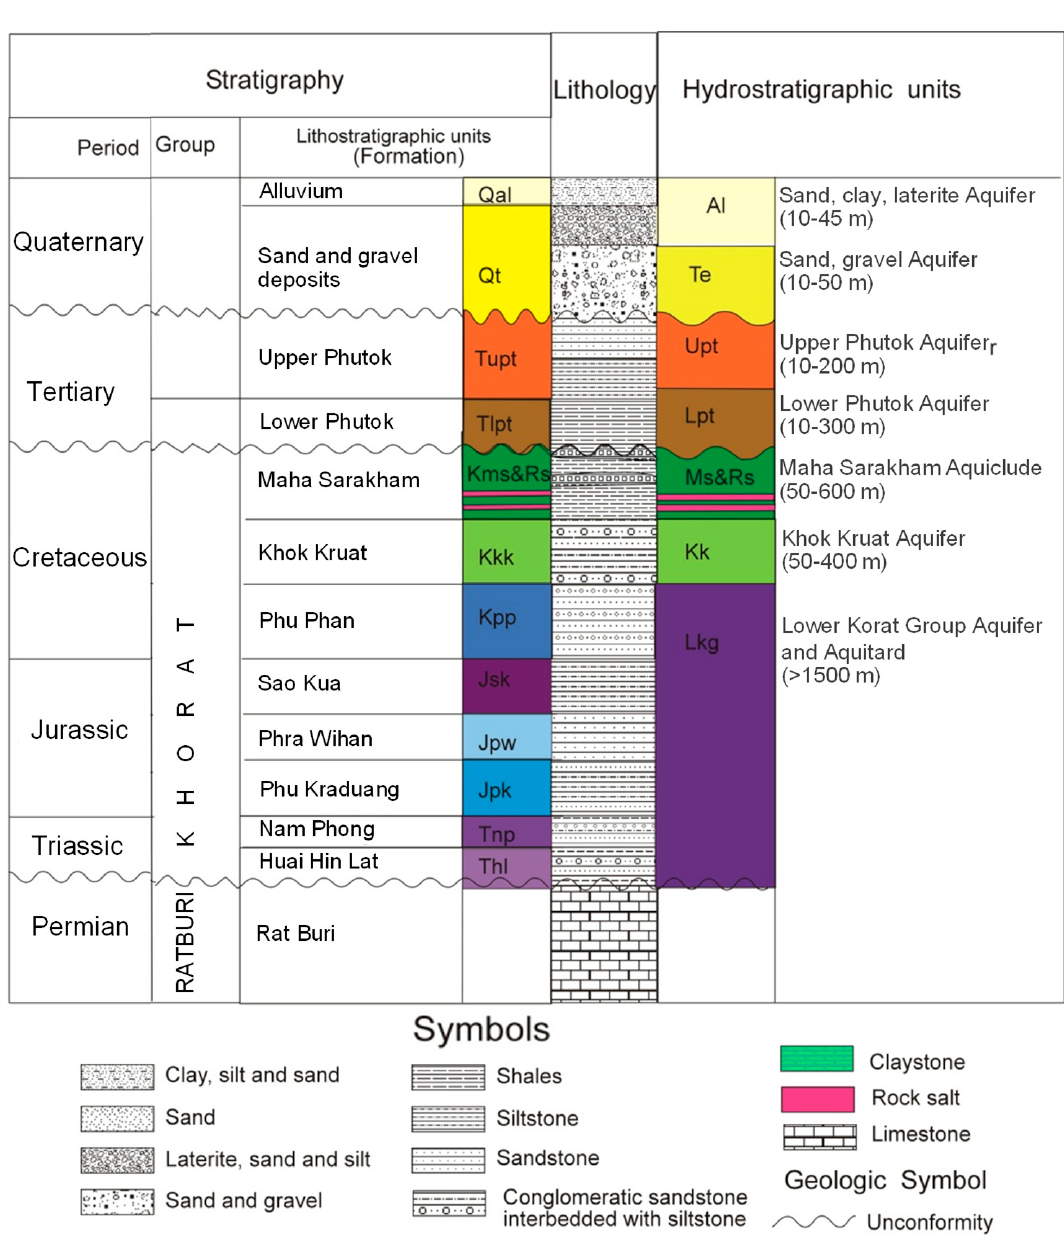
7 of 29 Table 1. Estimated ranges of aquifer properties by hydrostratigraphic units. Hydrogeologic Units